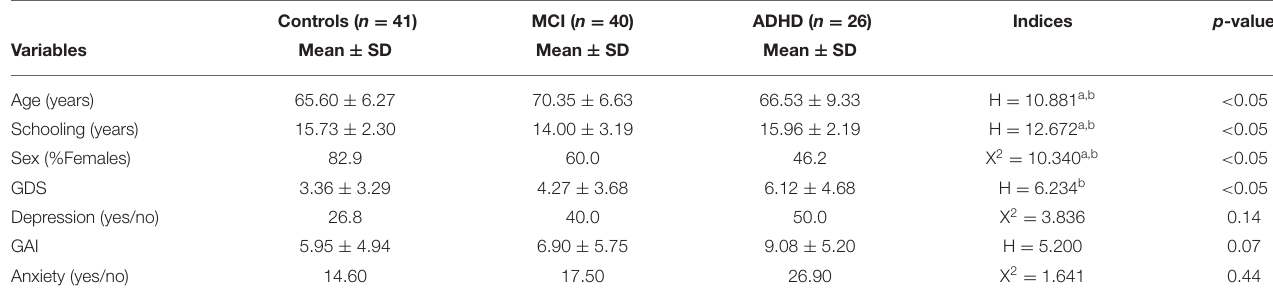
TABLE 1 | Sociodemographic, behavioral, and cognitive characteristics of the sample.